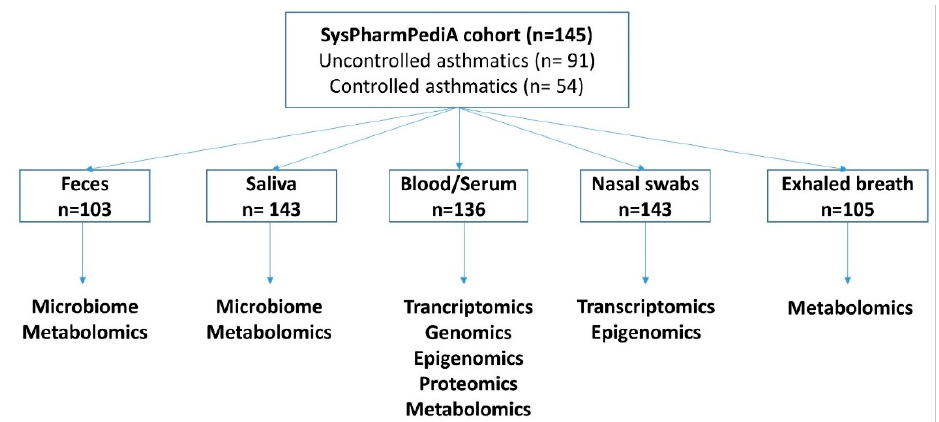
Figure 3. Consort flow diagram showing the total number of recruited subjects and the number of samples collected per body compartment. Five patients provided buccal swabs for genotyping as a replacement of the non-obtained blood samples.